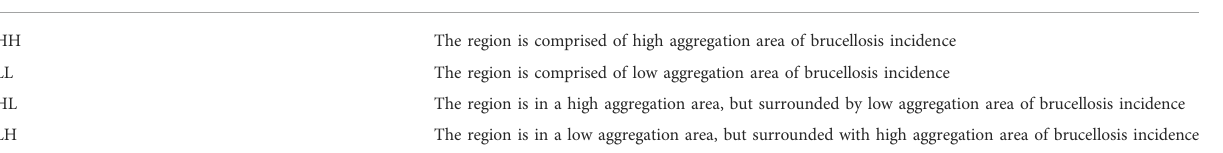
TABLE 1 Illustration of HH, LL, HL and LH. Attribute